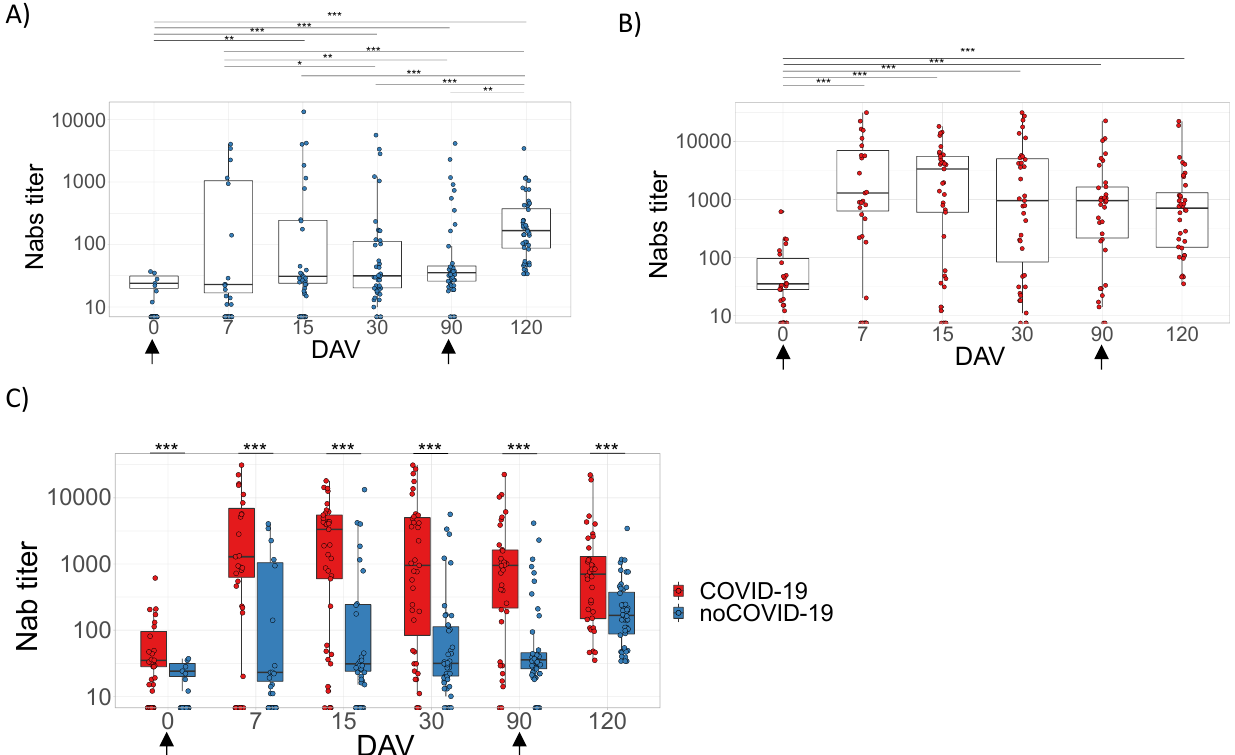
Figure 3. Neutralizing antibody (Nab) responses against infective SARS-CoV-2. Panels ( A – C ) refer to samples tested from volunteers immunized with the prime–boost protocol for ChAdOx1 nCoV-19 on days 0 and 90 (indicated by arrows). Individual serum samples were collected before vaccination (0 days = pre-immunization) to determine a baseline profile. In addition, volunteer samples were collected on days 7, 15, 30, and 90 post-first dose and 30 days after the second immunizing dose; this point is represented on the graphs as day 120. Panels ( A – C ) belong to volunteer groups including individuals without (noCOVID-19) or with (COVID-19) pre-vaccination SARS-CoV-2 infection and the comparison of these two groups. Sera were serially diluted from 1:10 to 1:31,250 and the PRNT50% was performed in 24-well plates. Asterisks indicate differences that are statistically significant (* p < 0.05, ** p < 0.01, and *** p < 0.001) as evaluated by Kruskal–Wallis tests with Dunn’s post-hoc tests ( A , B ) and Mann–Whitney tests ( C ). DAV = days after